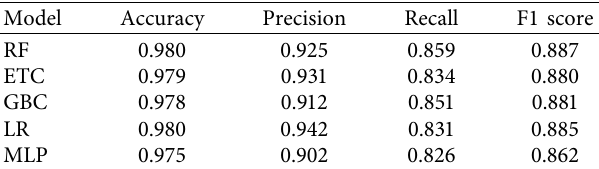
Table 8: Results of machine learning models without data resampling.